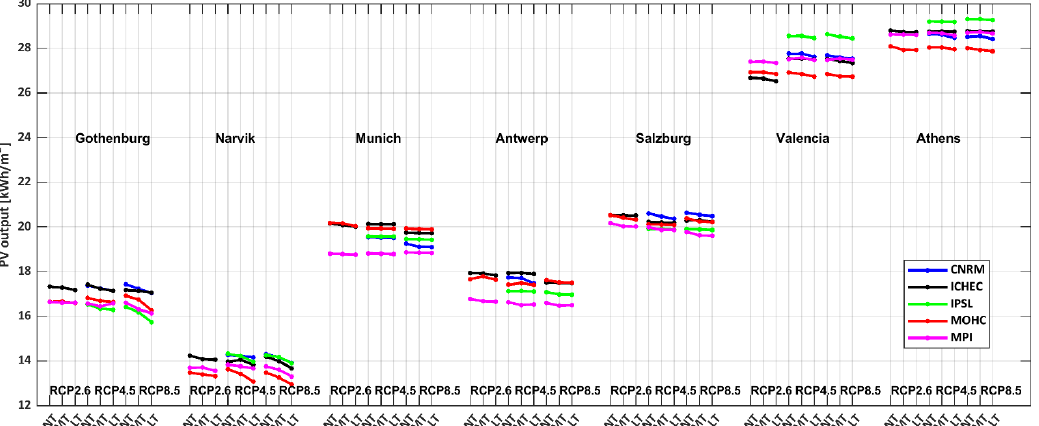
Figure 3. Average PV output in kWh/m 2 between NT, MT and LT at the hourly temporal scale for five GCMs: CNRM (blue), ICHEC (black) IPSL (green), MOHC (red), and MPI (pink).